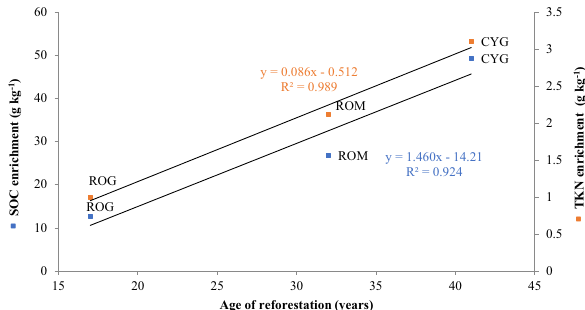
Figure 2. Linear regression between the age of each reforestation and the soil organic carbon enrichment. ROG black locust at Lama Giulia), ROM black locust at Locone Lake, CYG cypress at Lama Giulia.